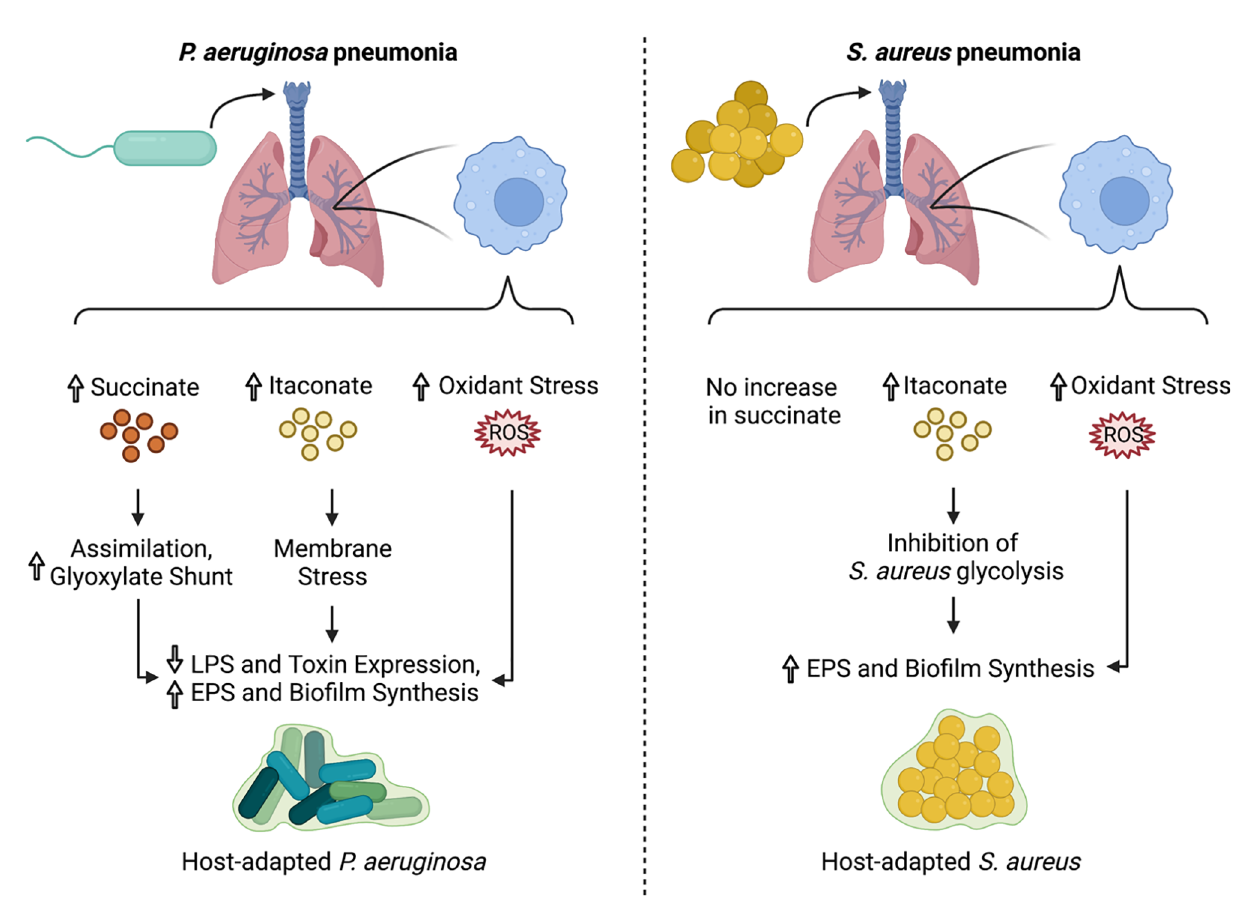
FIGURE 3 | Impact of immunometabolites on P. aeruginosa and S. aureus adaptation to the lung microenvironment. During infection with P. aeruginosa , airway immune cells produce succinate, itaconate, and ROS. This creates a strong selective pressure for isolates that adapt via metabolic rewiring, decreased LPS surface display and toxin production, and increased bio fi lm synthesis. In contrast, S. aureus infection induces accumulation of itaconate and ROS, but not succinate in the airway. Both itaconate and ROS select for metabolically-altered S. aureus strains that exhibit decreased glycolytic activity and increased EPS and bio fi lm